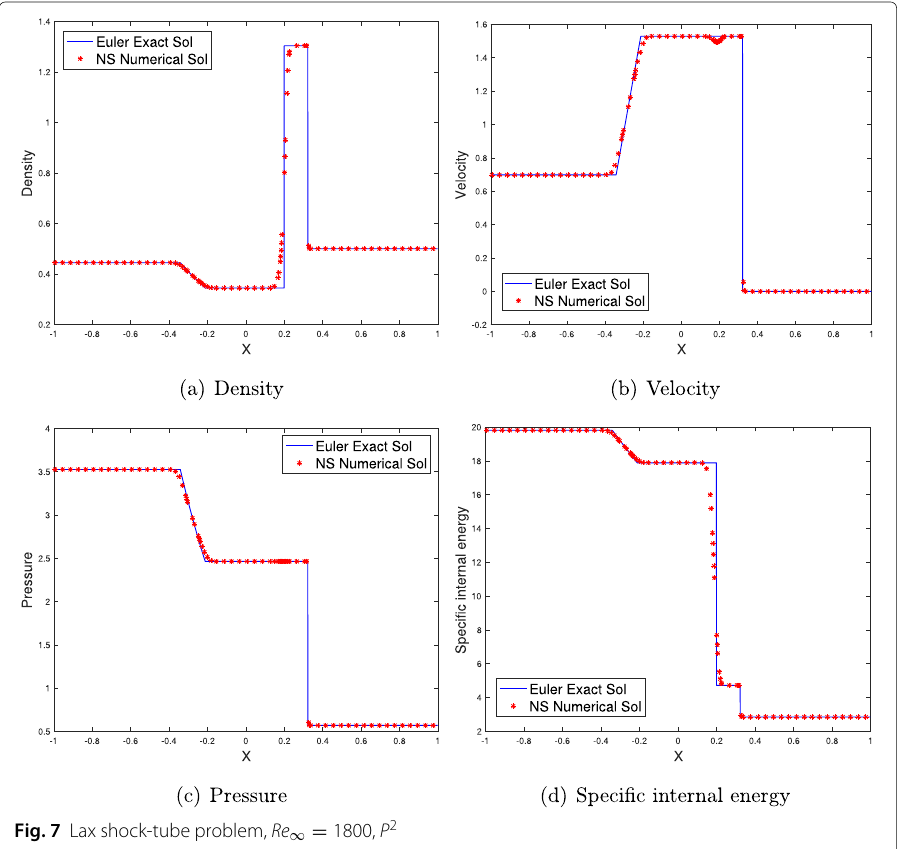
Fig. 7 Lax shock-tube problem, Re ∞ = 1800, P 2